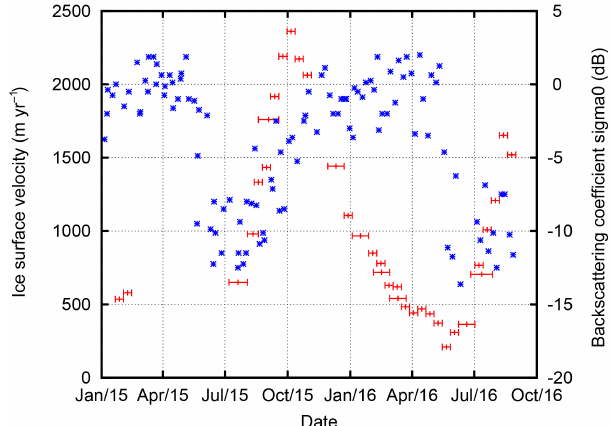
Figure 9. Time series of ice surface velocities close to the front of the southern lobe of Stonebreen (716080 ◦ E/8646230 ◦ N). For position see Fig. 2.